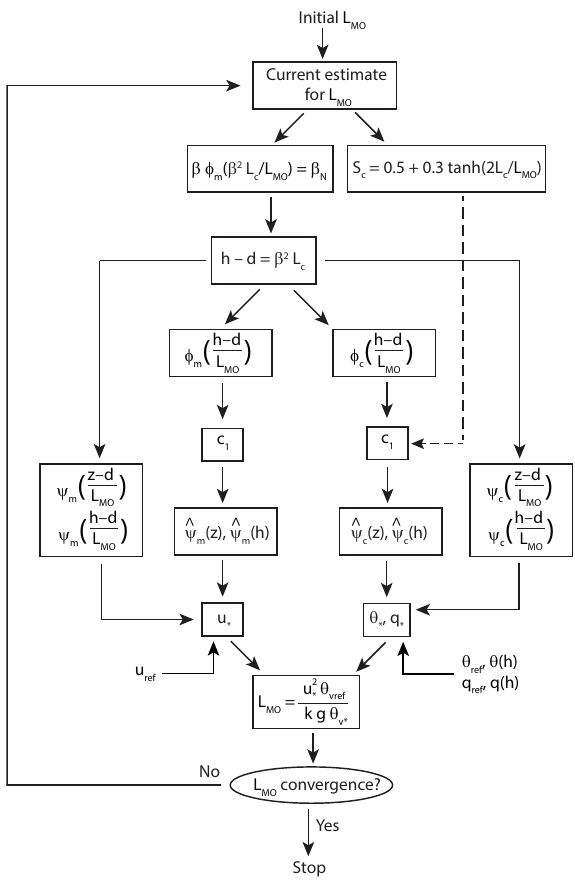
Figure 2. Flow diagram for calculating the Obukhov length ( L MO )